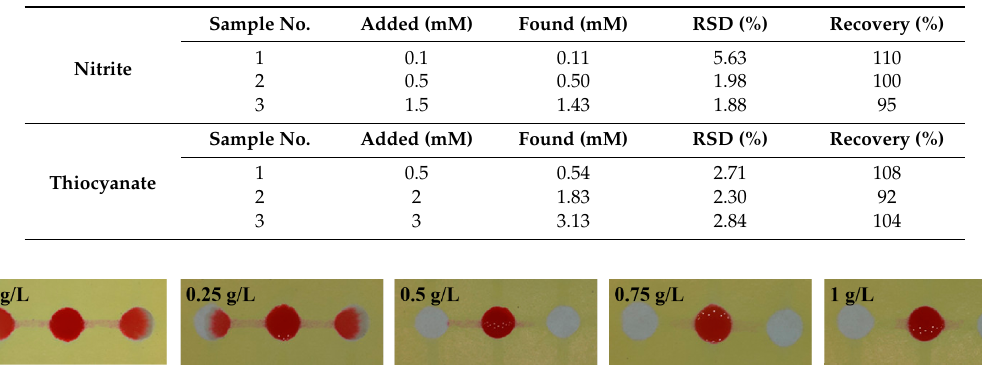
Table 2. Recovery test of nitrite and thiocyanate in artificial saliva.